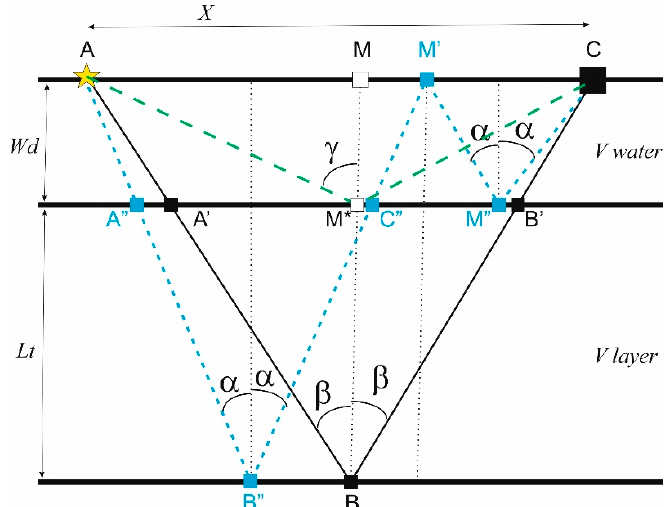
Figure 1. Ray paths from a source (point A) to a receiver (point C): primary reflections from the seafloor (dashed green line) and the layer bottom (continuous black line), and a peg-leg multiple reflection (dashed blue line).